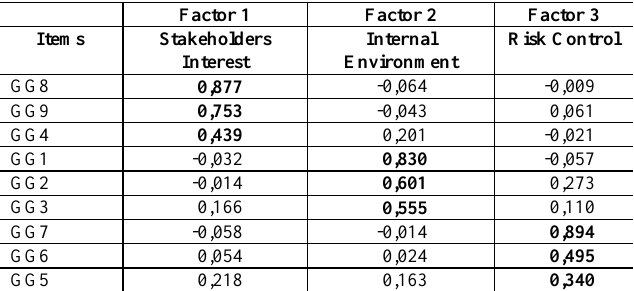
Table 3: Quartimax rotated factor matrix: The dependent variables